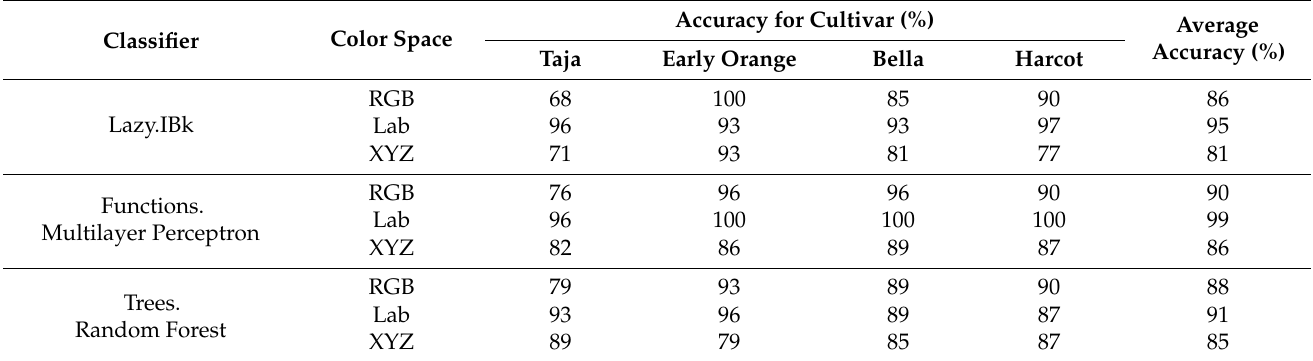
Table 2. The accuracies of cultivar classification of apricot seeds based on textures selected from color